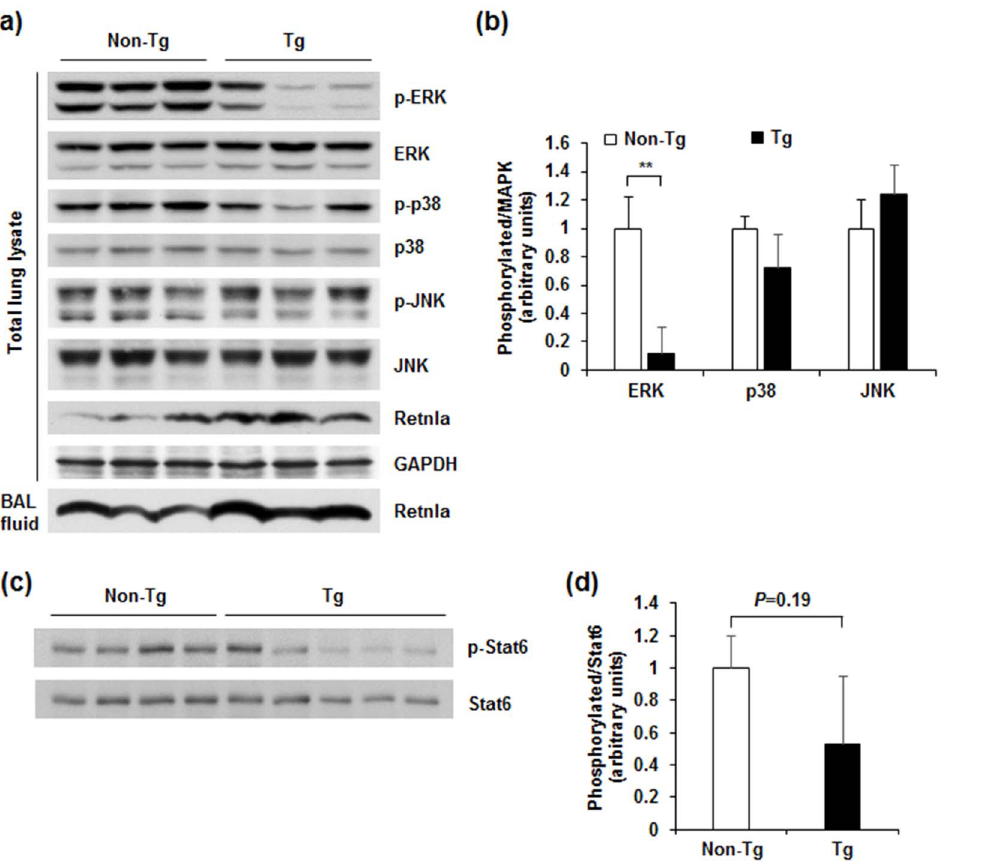
Figure 7. Retnla overexpression reduced ERK activation in OVA-induced asthmatic lung. (a,c) The phosphorylation of MAPKs (ERK, p38, and JNK) (a) and STAT6 (c) in lung tissue was analyzed by immunoblotting. Each lane represents an individual mouse. (b,d) Band intensities in the immunoblot were quantitated by computerized densitometry. The phosphorylation of ERK was markedly reduced in Retnla -Tg mice. Data are presented as mean ¡ SD. Statistical analysis was performed with the Mann-Whitney U -test; ** P ,